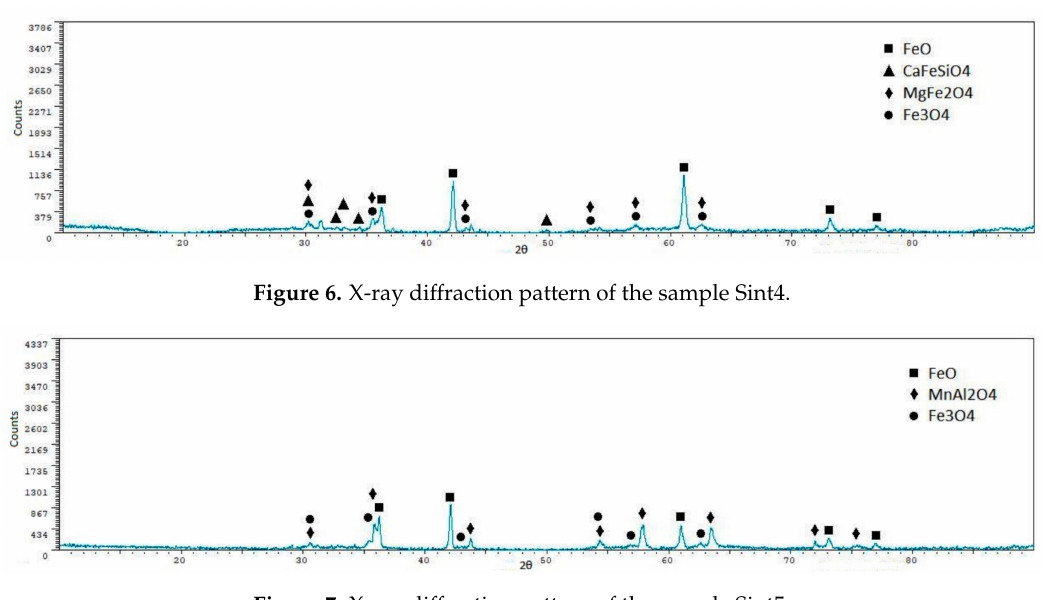
Figure 7. X-ray diffraction pattern of the sample Sint5.